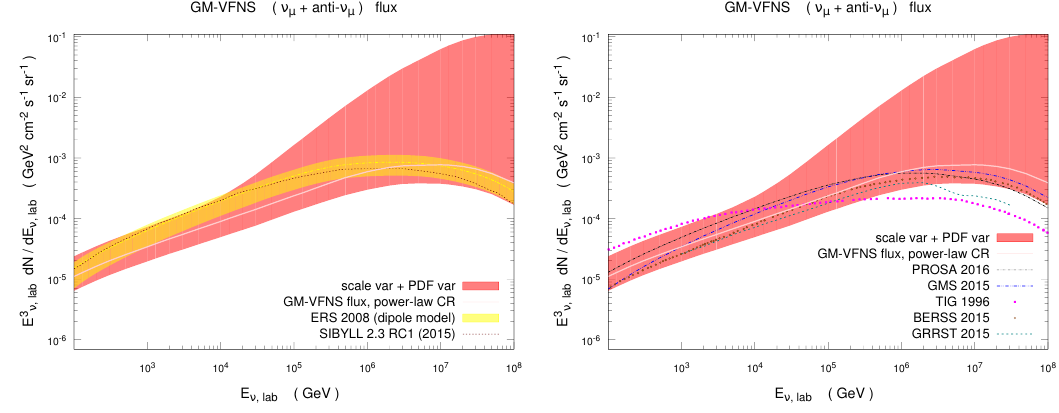
Figure 13 . Prompt-( (cid:23) (cid:22) + (cid:22) (cid:23) (cid:22) ) (cid:13)uxes as a function of neutrino energy E (cid:23); lab . Predictions according to the GM-VFNS computation of this paper, together with their uncertainty band, are compared to other ones available in the literature [4, 5, 49, 73{75], distinguishing those making use of phe- nomenological models (the dipole model and a recent version of the SYBILL event generator), shown on the left, from those treating charm hadroproduction at parton-level by means of perturbative QCD, collected in the plot on the right. The broken power-law CR primary spectrum is used as input in all predictions.